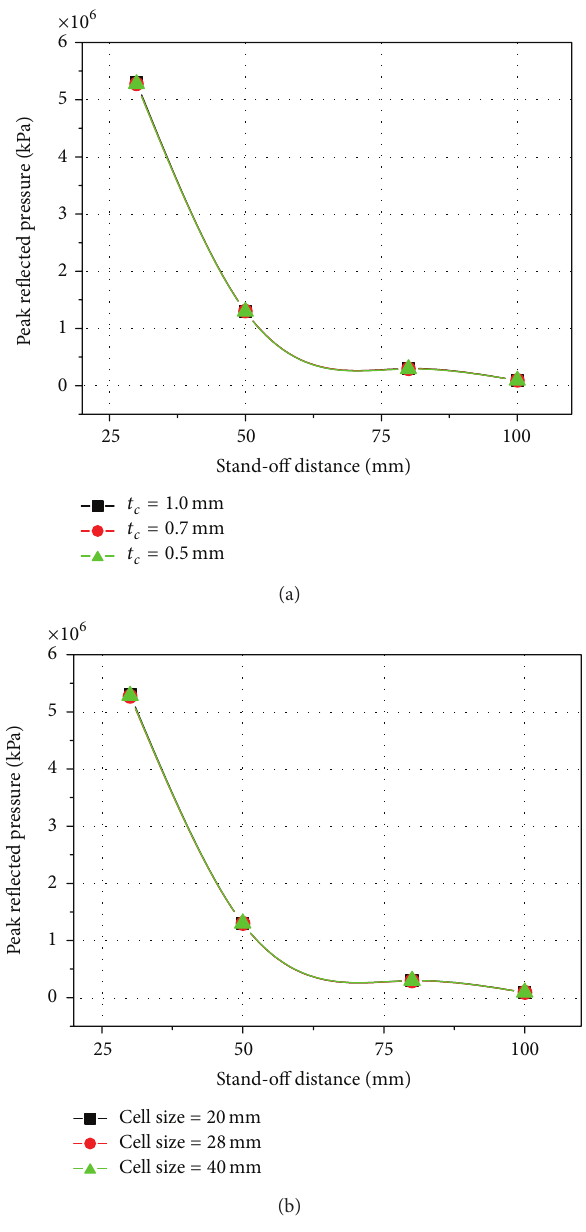
Figure 17: Peak reflected pressure of midpoint of sandwich panels with (a) different core web thicknesses and with (b) different cell